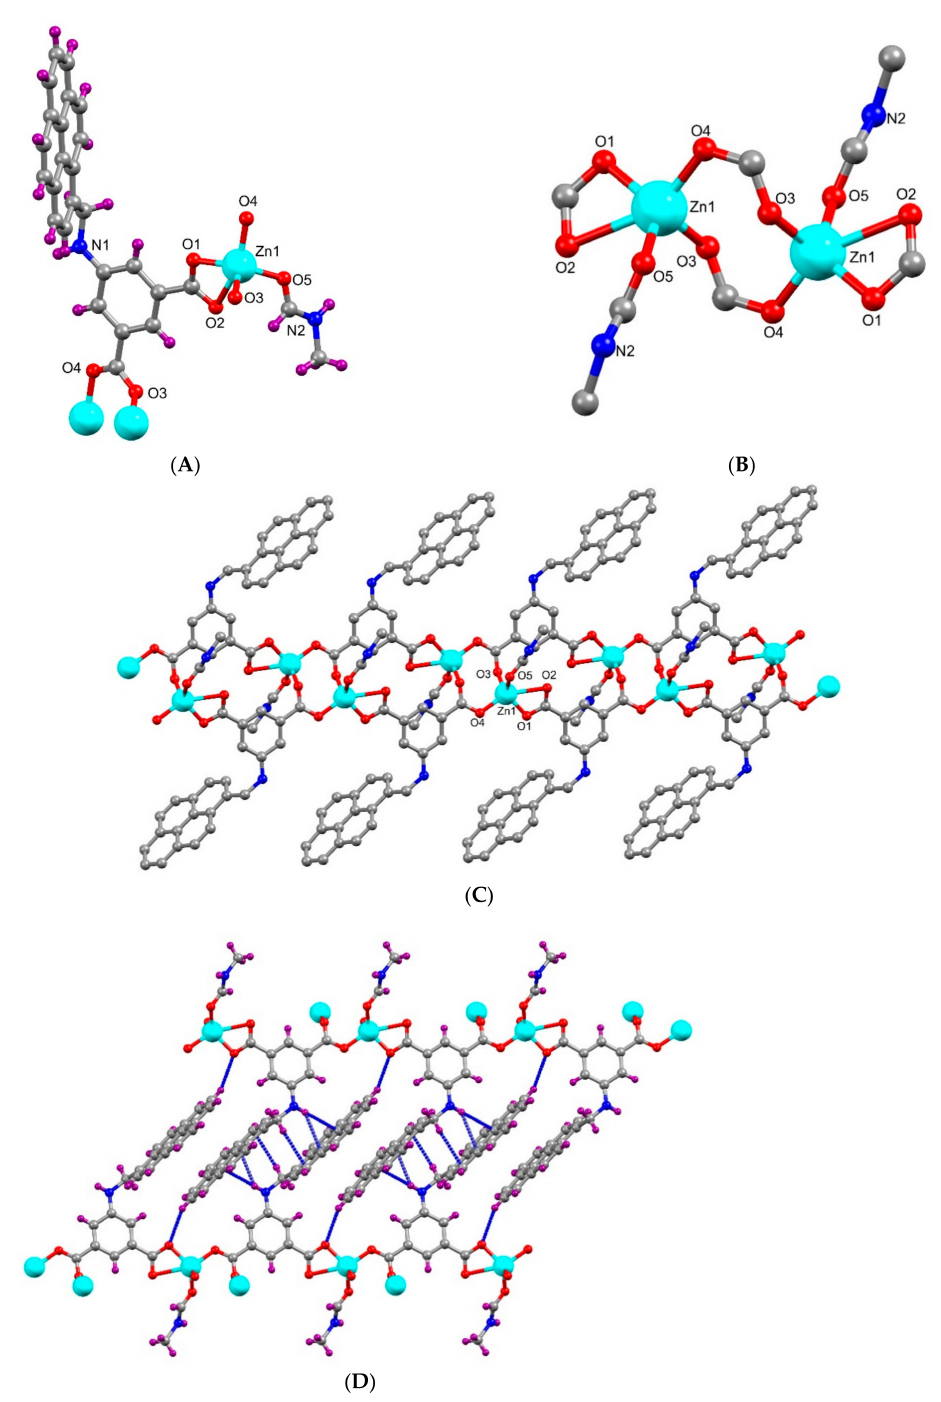
Figure 2. ( A ) Molecular structure of CP 1 with partial atom labelling scheme. ( B ) Schematic represen- tation of binuclear SBU. ( C ) One-dimensional double chain-type structure of CP 1 . ( D ) Hydrogen bonding between two 1D chains of CP 1